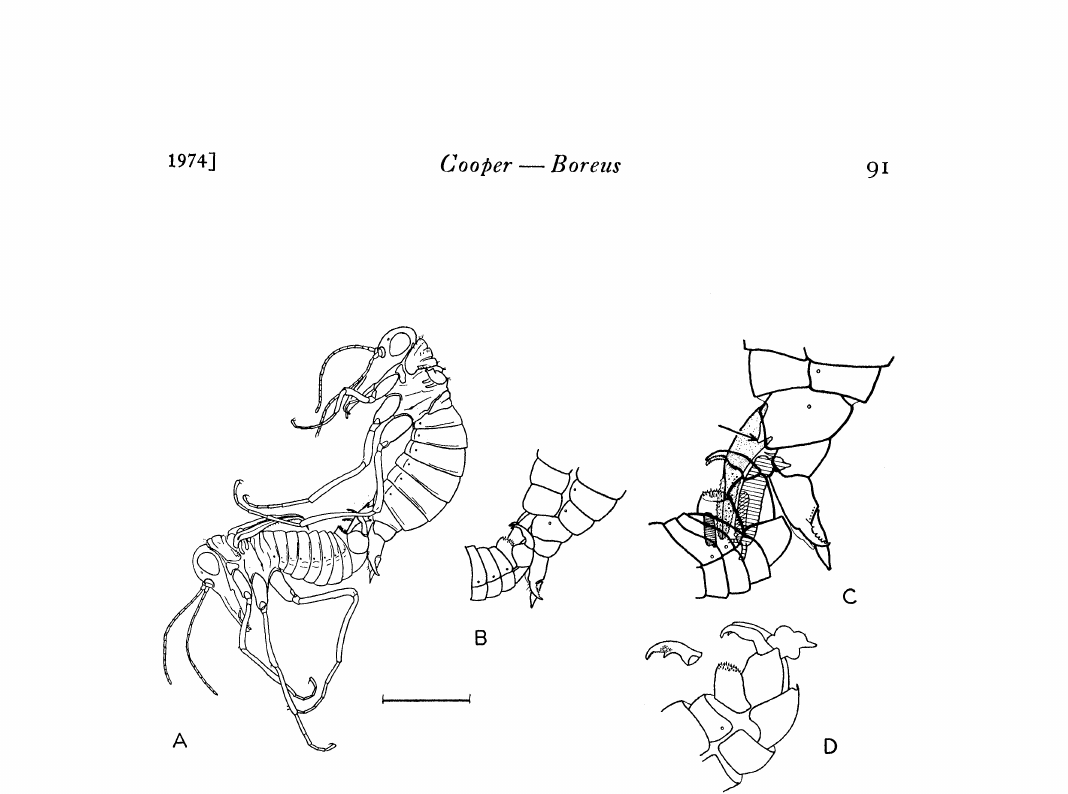
Fig. 1. Mating of Boreus notolerates. A, mated pair preserved in female perpendicular position; the medial tooth of the gonostylus has disengaged (at death) from the lateral basal notch of the gonapophysis. B, full union of male and female; medial tooth of gonostylus seated into the lateral basal notch of the gonapophysis; C, semi diagrammatic representation of mated specimens cleared in clove oil; as in A, the gonapophysis is partially with- drawn rom the endandrium, and the lateral basal notch of the gonapophysis (at arrow) is clearly visible; dorsal proetigeral plate (closely, transversely lined) lies within epandrial notch gonapophyses stippled aedeagus (widely, transversely lined) partially inserted in common oviduct--note flap at anterior margin of female gonopore and paired ejaeulatory ducts entering base of aedeagus; the sclerotized lamina that forms floor of endandrium is cross-hatched (see text). D, male terminalia with everted aedeagus, apical nipple of which bears the gonopore; upper left--inner face of right gono- style to show median tooth and styloeavernula. All from camera lucida sketches; scale: or A and B equals mm, for C and D equals 0.5